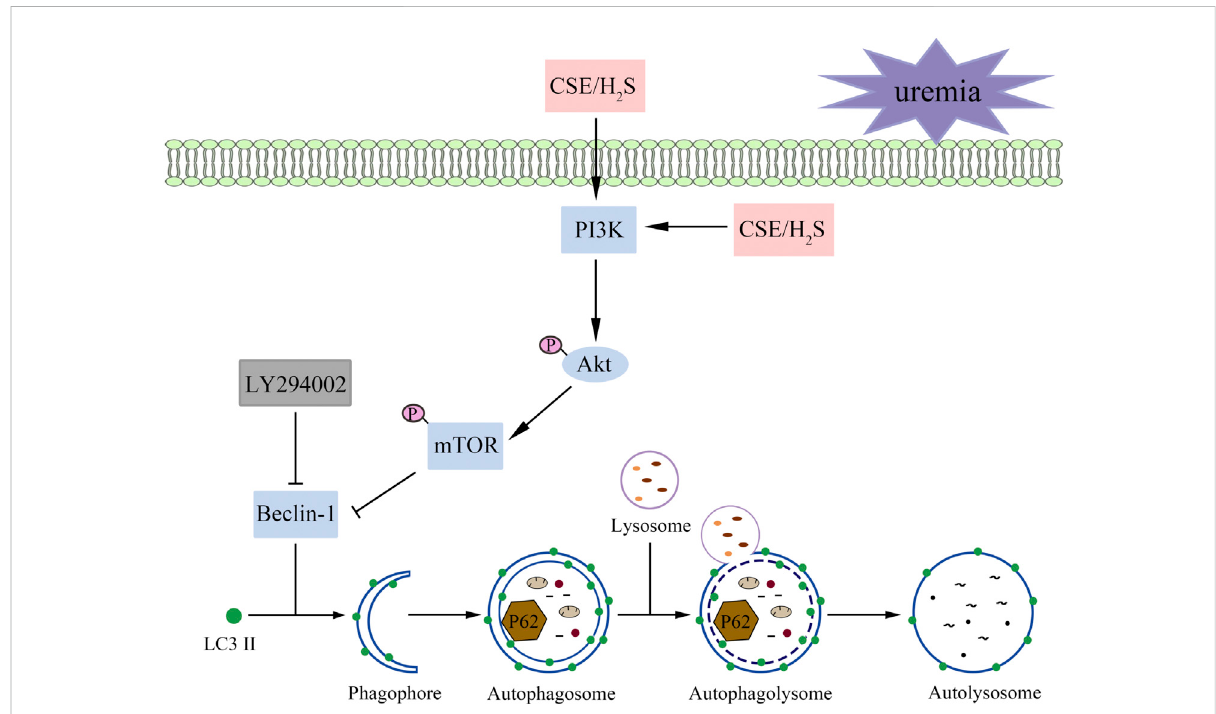
FIGURE 9 A proposed model illustrating the therapeutic effect of H 2 S on UCM. Uremia inhibits the phosphorylation of PI3K in the heart and results in the heart dysfunction of UCM mice, while H 2 S increases the phosphorylation levels of PKB, PI3K, and mTOR and attenuates overactive autophagy. In summary, H 2 S alleviates uremic cardiomyopathy by regulating PI3K/PKB/mTOR-mediated autophagy in 5/6 nephrectomy